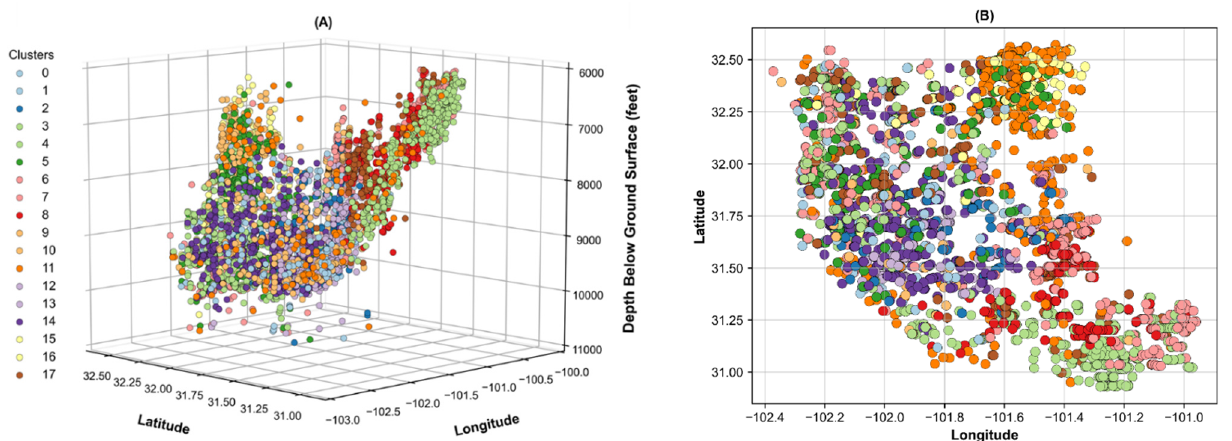
Figure 7. Well data demarcated by color corresponding to one of the 18 clusters (labeled 0–17 based on Python’s zero-based indexing). The top ( A ) is a three-dimensional representation of well data location which features placement along burial depth. The bottom ( B ) is a top-down depiction featuring well location by latitude and longitude coordinates only.